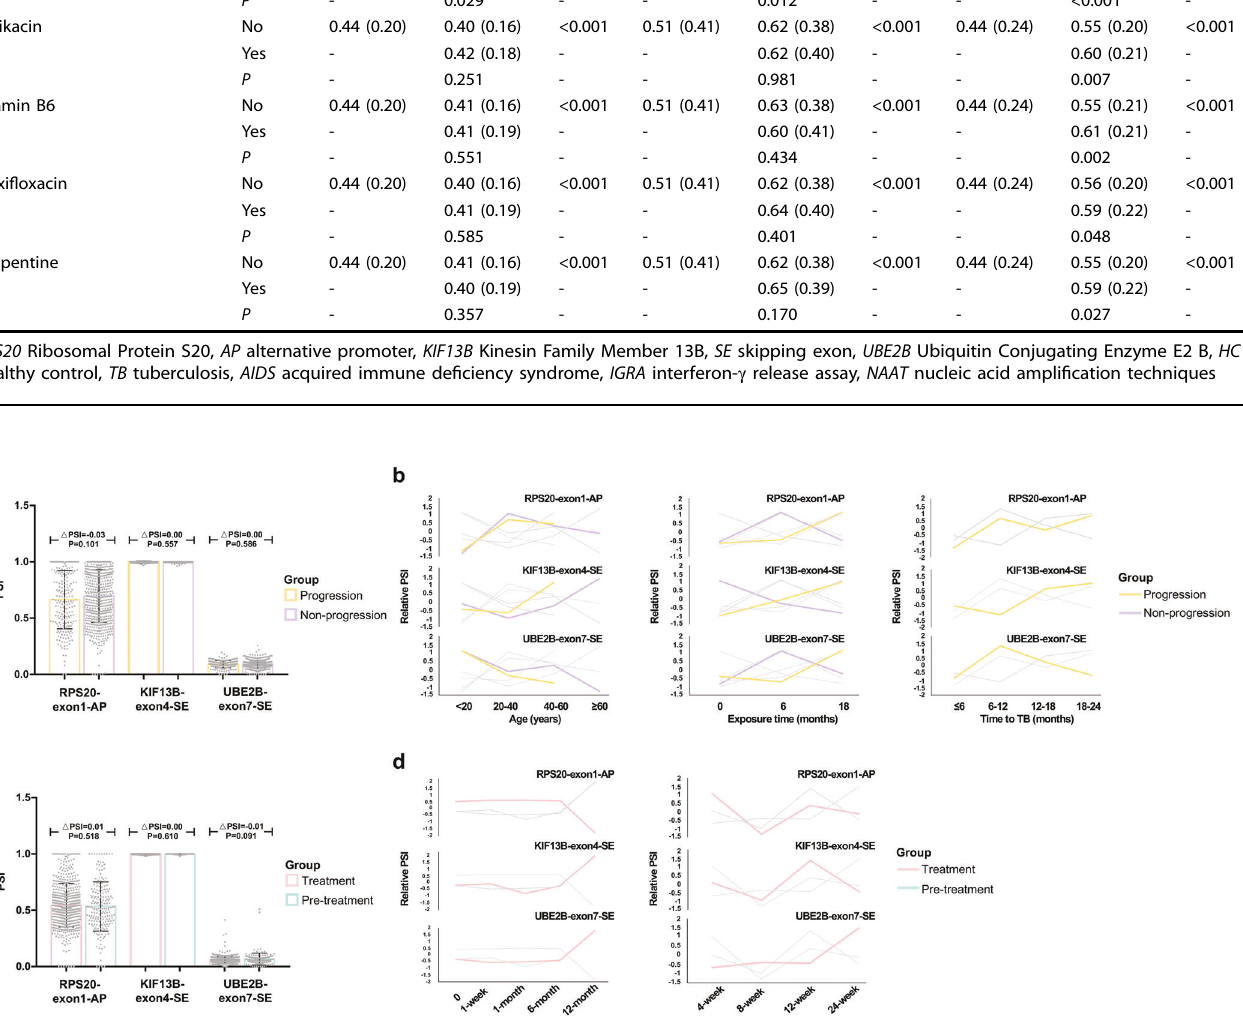
Signal Transduction and Targeted Therapy (2023)